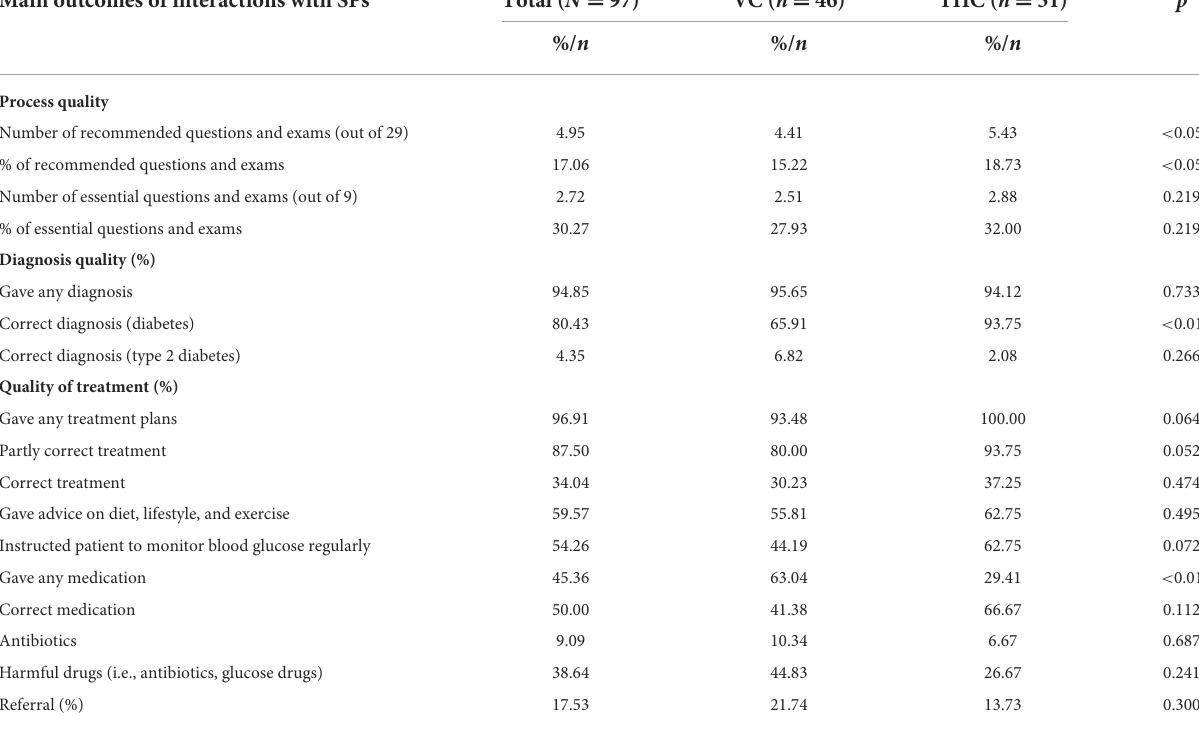
TABLE 4 Main outcomes of interactions with Standardized Patients (SPs) for diabetes. Main outcomes of interactions with